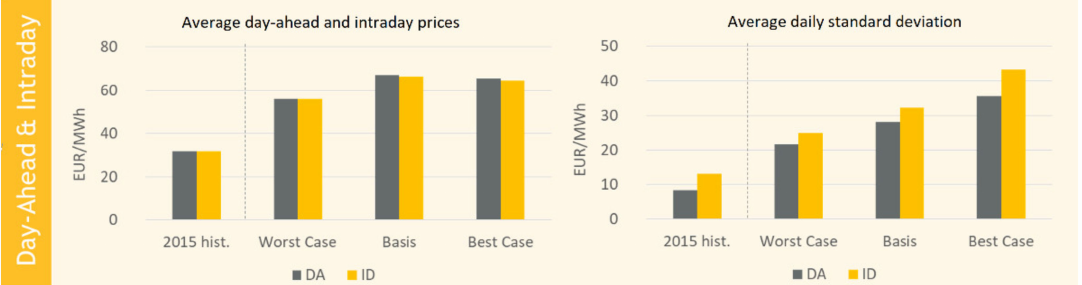
Figure 27. Day-Ahead and Intraday prices in Germany in 2030.